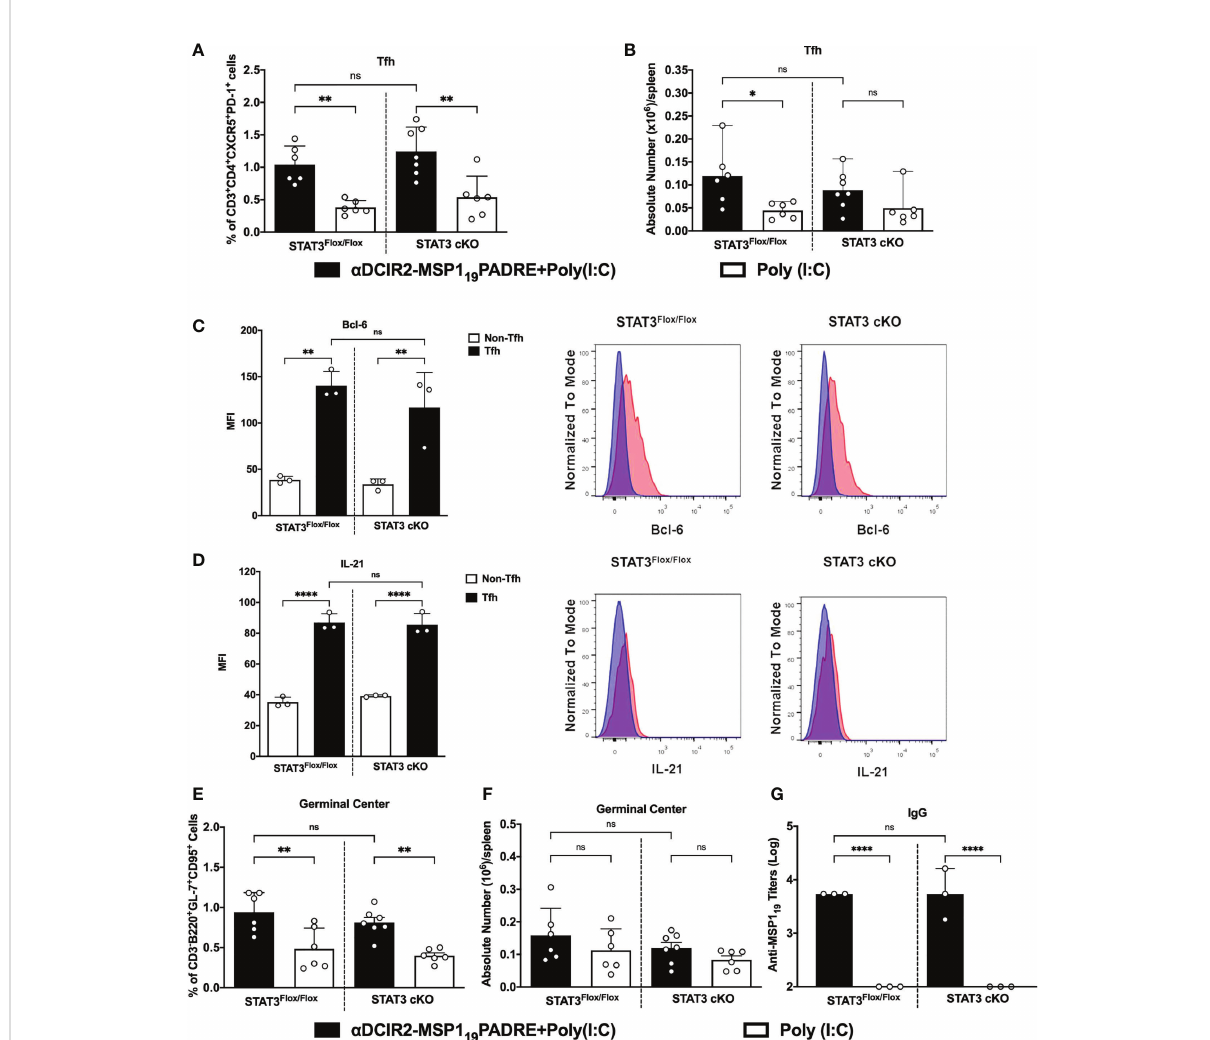
FIGURE 2 STAT3 signaling pathway does not control cDC2 ability to prime Tfh cells after antigen targeting to the DCIR2 receptor. STAT3 Flox/Flox and STAT3 cKO mice were immunized with 5 m g of a DCIR2-MSP1 19 PADRE together with 50 m g of Poly (I:C) as adjuvant or only Poly (I:C) as a control. Splenocytes were obtained 5 days later and Tfh cells, GC B cells and plasma cells were analyzed by fl ow cytometry, and anti-MSP1 19 IgG titers were determined by ELISA. (A) Frequency of Tfh cells in CD4 + T cells. (B) Absolute numbers of Tfh cells in the spleen. Bcl-6 and IL-21 were stained after fi xation/permeabilization and their expression on Tfh cells was detected by fl ow cytometry. (C) MFI for Bcl-6 was determined in Tfh (CD3 + CD4 + CXCR5 High PD-1 High ) and non-Tfh cells (CD3 + CD4 + CXCR5 - PD-1 - ). (D) MFI for IL-21 was determined in Tfh and non-Tfh. Histograms in blue show non-Tfh and in red Tfh cells. (E) Frequency and (F) absolute numbers/spleen of germinal centers (GL7 + CD95 + CD3 - B220 + ). (G) Sera were titrated to detect speci fi c anti-MSP1 19 IgG antibodies by ELISA. Bars show mean ± SD from two experiments pooled together (n=6-7 animals/group) in (A, B, E, F) and from one experiment (n=3 animals/group in (C, D, G) . *p<0.05, **p<0.01, ****p<0.0001, and ns not signi fi cant; one-way ANOVA followed by Tukey ’ s